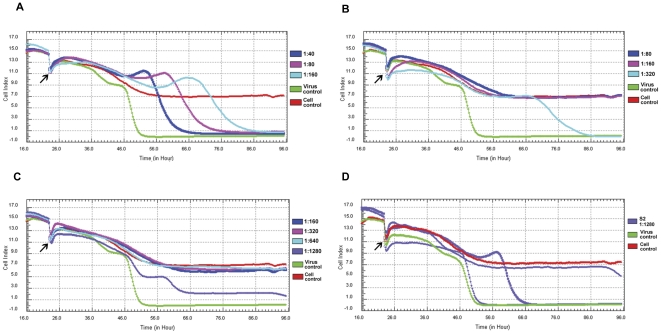
Typical results of real-time neutralization tests against SH37T.CPE kinetic patterns of MDCK cells inoculated with 100 TCID50 virus incubated with a series dilution of sera samples. Antibody titers were calculated as a function of CI with a sequential dilution series of S0 (A), S1 (B), and S2 (C). The curve was an average of three independent replicate wells. At the indicated time point the cells were inoculated with the serial serum-virus mixture. Three replicate wells of 1280-fold diluted S2 treated cells showed different curves (D). Cell control: MDCK cells only; virus control: absence of test sera.